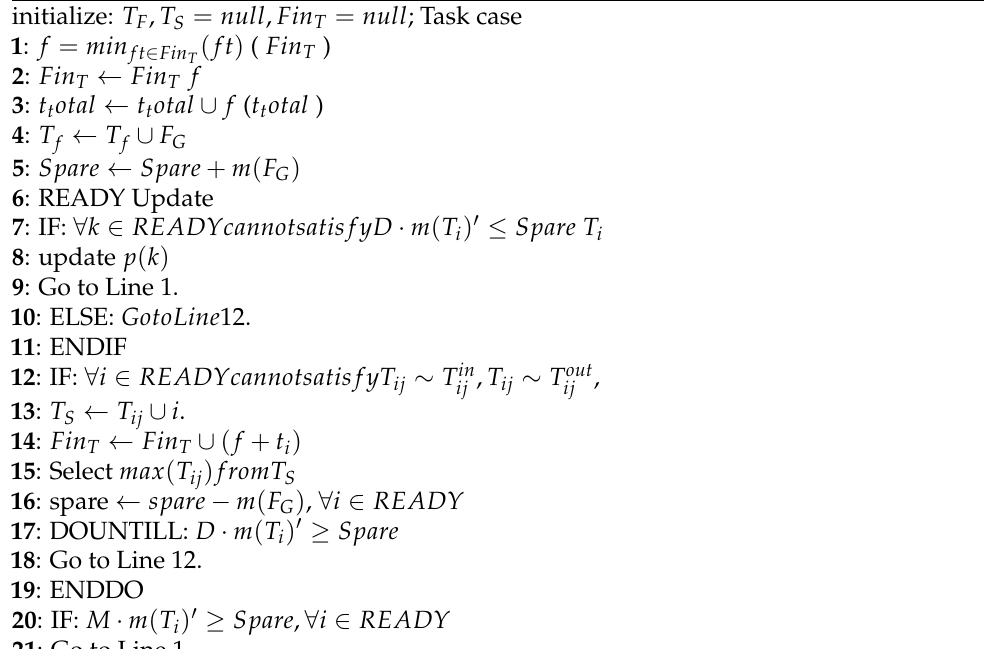
Algorithm 1 Swarm reconstruction scheduling